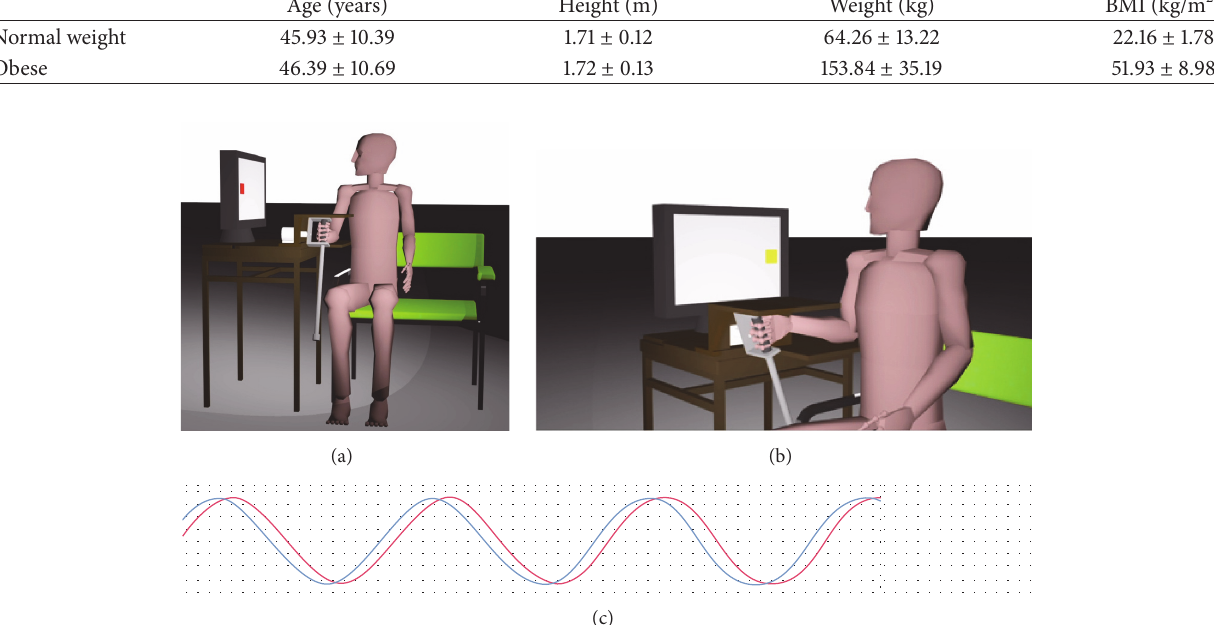
Figure 1: Experimental set-up. Participants sat in a bariatric chair and were asked to swing the pendulum forward as the square moved left and faded to a red colour (a) and backward as the square moved right on the screen fading to a yellow colour (b) synchronizing the endpoint of the movements with the square’s endpoints. From the resting position of the pendulum, participants swung the pendulum to a 45 ∘ angle to the left and a 45 ∘ angle to the right. (c) Participants’ pendulum position was recorded using a potentiometer and compared with the computer generated stimulus (cf.